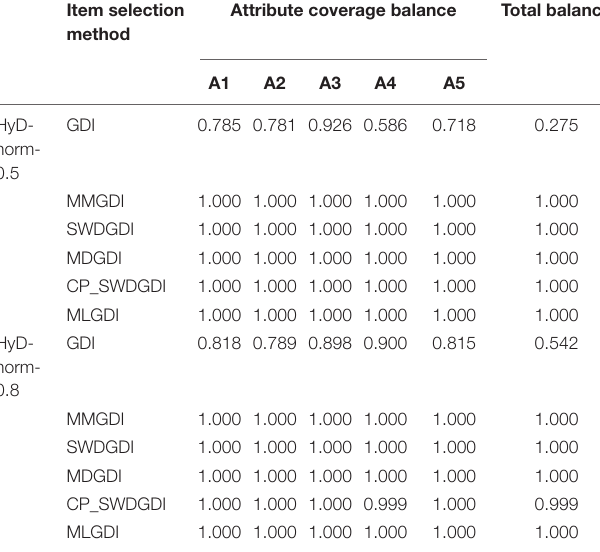
TABLE 6 | Attribute coverage balance of each item selection method under five